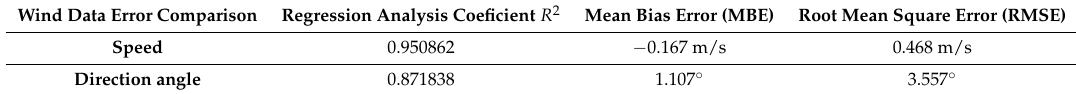
Table 1. Data comparison. Error of measurements.